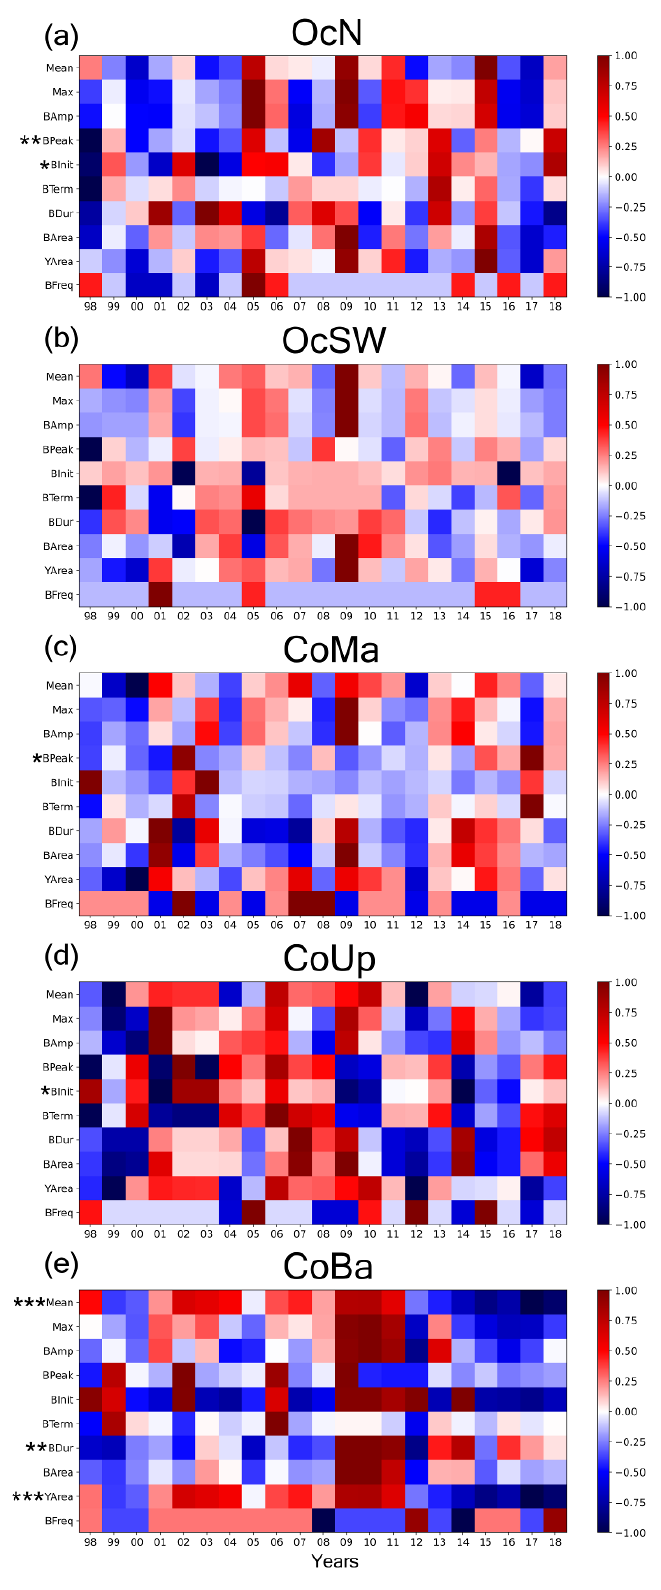
Figure 8. Yearly phenology metrics anomalies between 1998 and 2018 for each phenoregion: ( a ) OcN, ( b ) OcSW, ( c ) Co- Ma, ( d ) CoUp, ( e ) CoBa (normalized between − 1 and 1). Asterisks represent significant positive linear trends, as seen in Table 2. ***, **, and * correspond to the degree of statistical significance (p-value < 0.1, p-value < 0.05, p-value < 0.01, re- spectively).